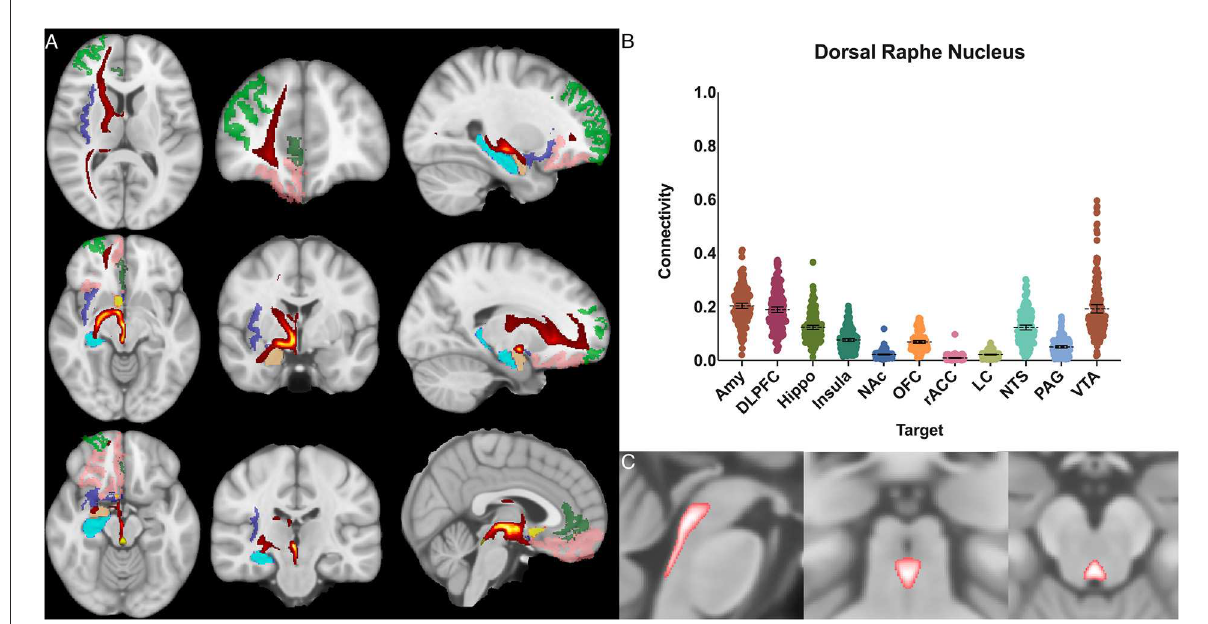
FIGURE3 Dorsal raphe nucleus structural results. (A) MNI space structural connectivity results visual representation averaged over all 197 subjects. Brighter yellow on heat map indicates a high number of samples passing through a given point that will eventually reach a target map (brighter yellow = more samples). Dark green: DLPFC; pink: OFC; brown: AMY; blue: HIPPO; purple: insula; orange: NAc; light green: rACC. (B) Mean connectivity results with dashed line showing mean and 95% CI, each point on graph shows result from individual subject. (C) Anatomic MNI mask of seed region.